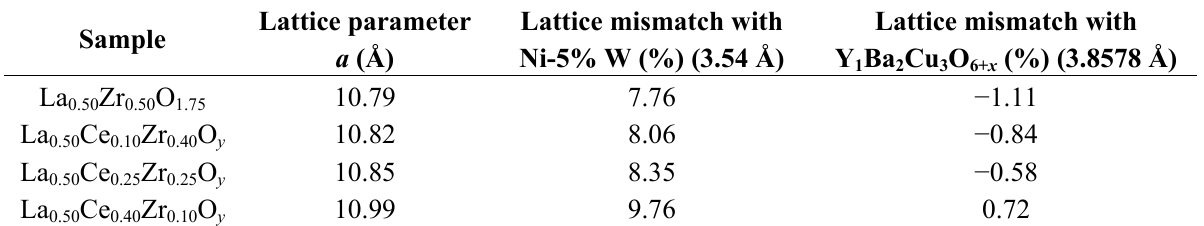
Ce Zr O thin films and their lattice 0.50 x 0.5 − x y